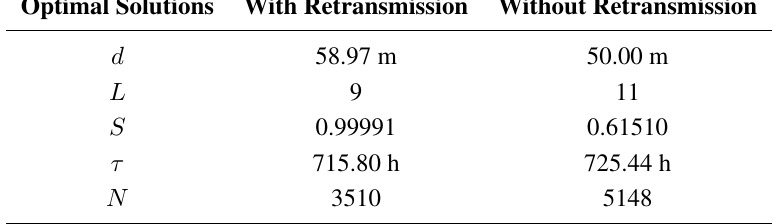
Table 3. Optimization results of uniform deployment. The details of the symbols can be seen in the Appendix.